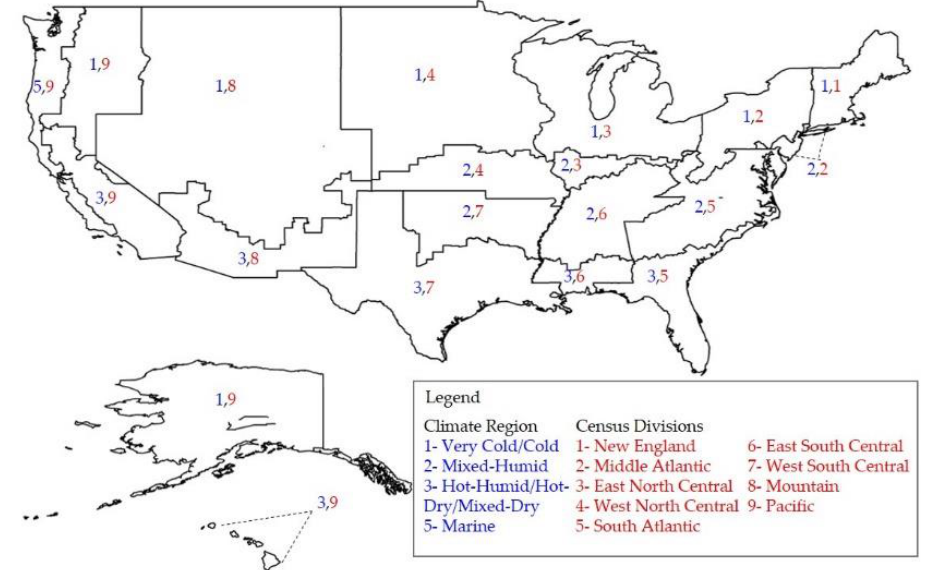
Figure 4. USA Geographic regions. Geographic regions are specified by unique codes that consist of climate regions and census divisions. #,# refers to climate region (blue text) and census division (red text), respectively.